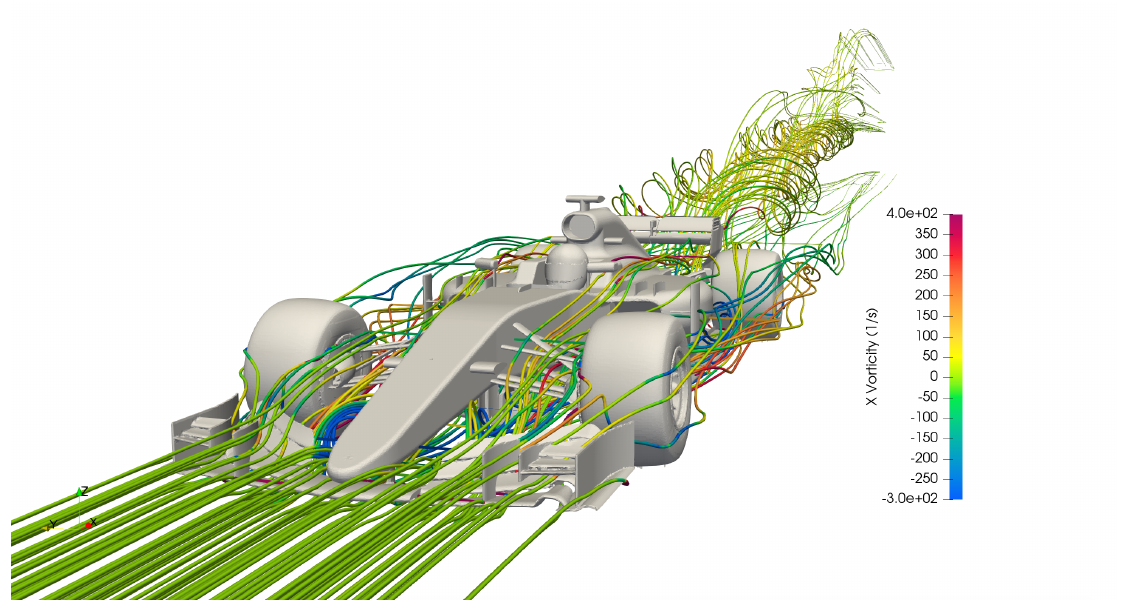
Figure 11. Streamlines of the axial vorticity.